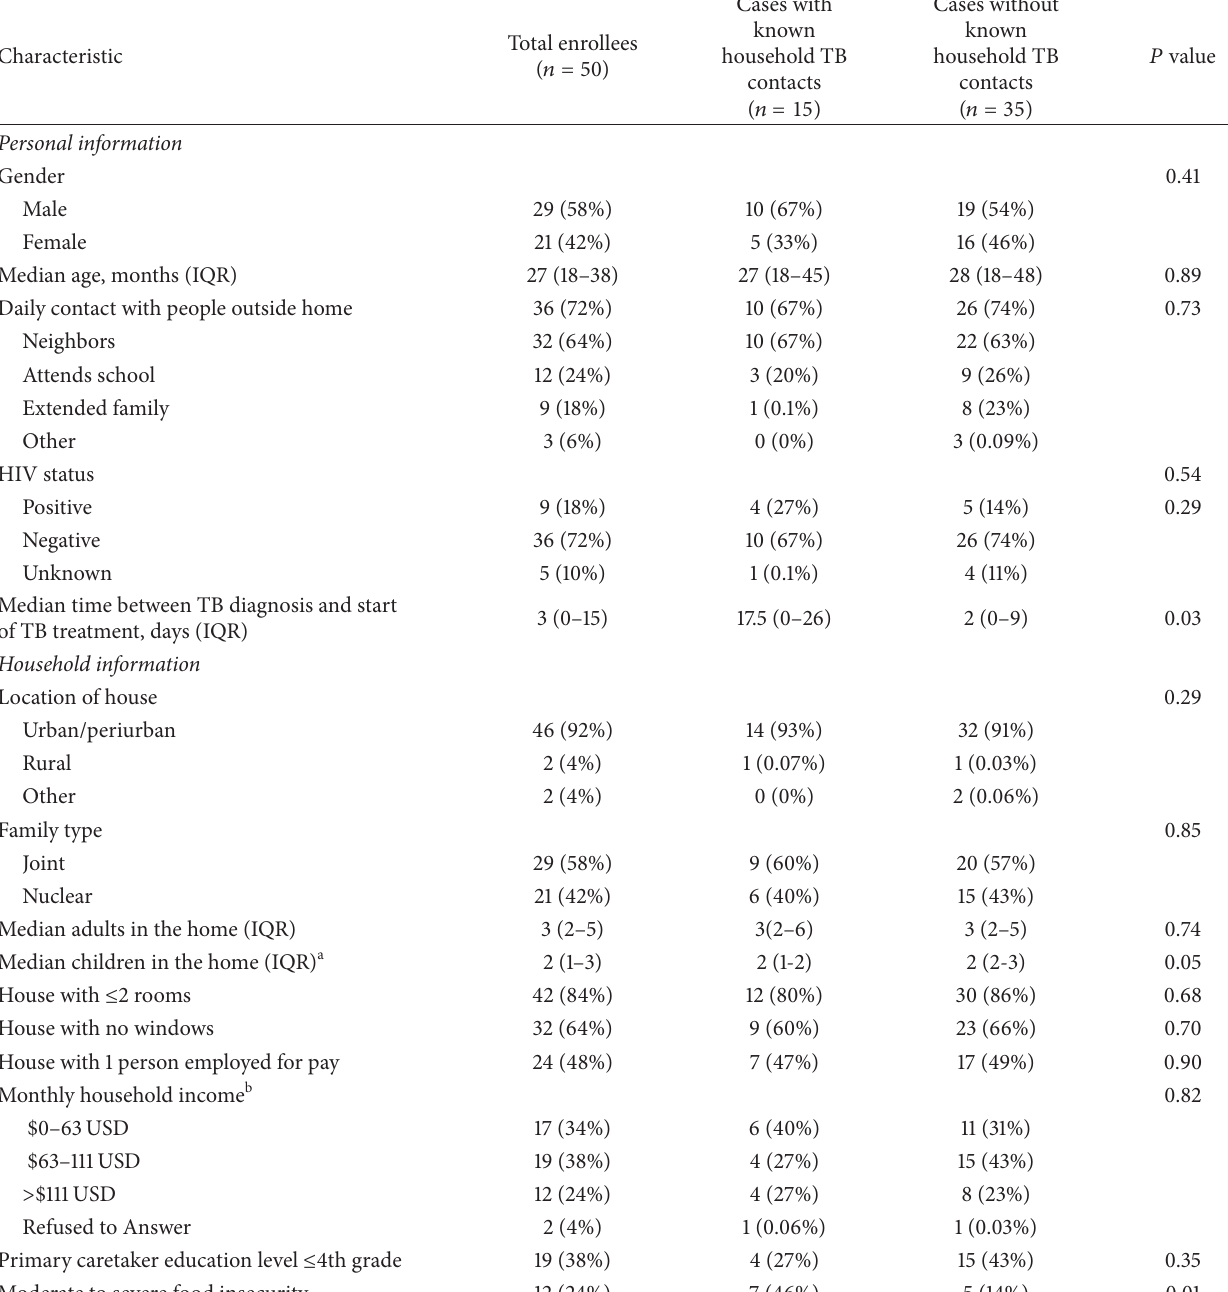
Table 1: Sociodemographic and clinical characteristics of pediatric index